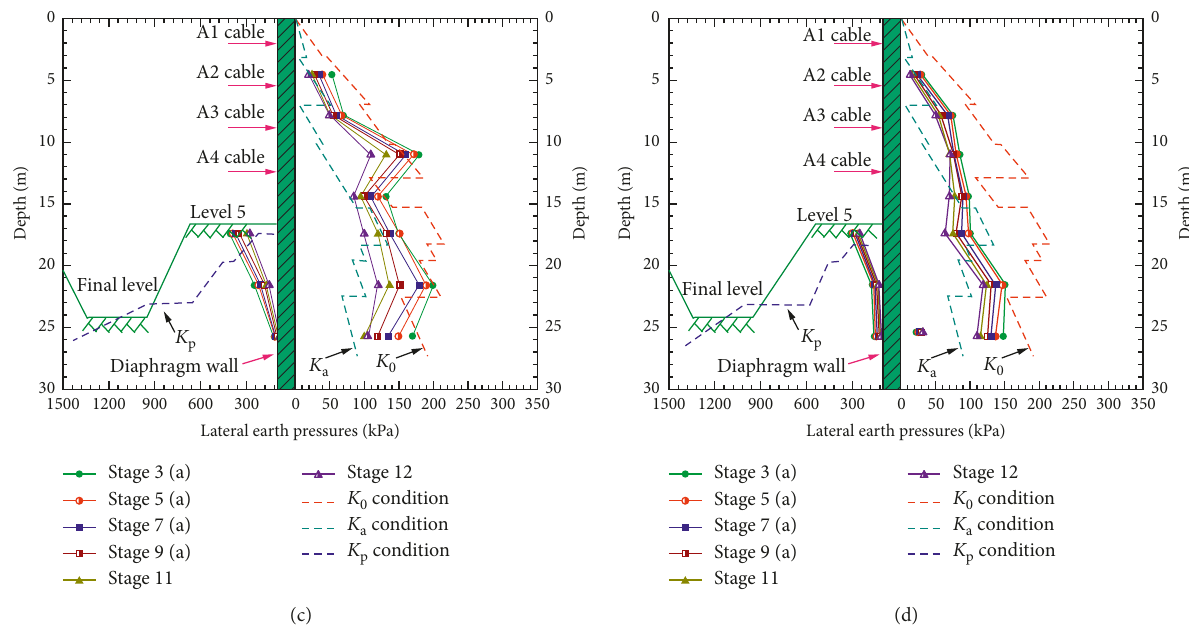
Figure 16: Distribution of the measured lateral earth pressures along depth at different construction stages. (a) The east segment. (b) The north segment. (c) The west segment. (d) The south